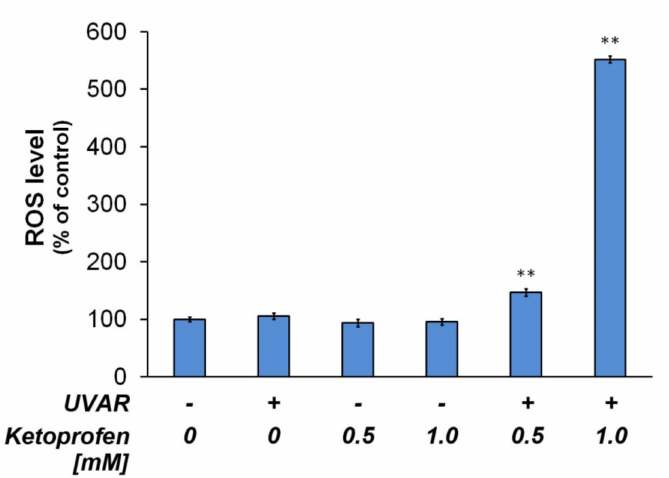
Figure 7. Redox homeostasis in melanoma COLO829 cell line exposed to KTP and UVAR. The cells were exposed to the drug (at concentrations of 0.5 and 1.0 mM for 24 h) and UVAR. Intracellular reactive oxygen species (ROS) level determined by H 2 DCFDA assay and calculated as the percentage of control. ** p < 0.001 vs. control (one-way ANOVA, two-way ANOVA, Tukey